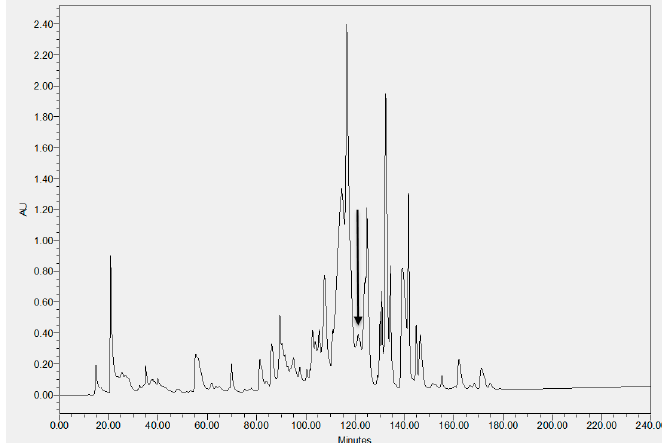
Figure 4. Reverse-phase high performance liquid chromatography (RP-HPLC) chromatogram of lyophilised skin secretion of Pithecopus hypochondrialis . The arrow indicates the retention time/elution position of the fraction containing a peptide with a mass coincident with that of Dermaseptin-PH. The absorbance was set at λ = 214 nm. The X -axis indicates the retention time in minutes and the Y -axis indicates the relevant absorbance in arbitrary units.